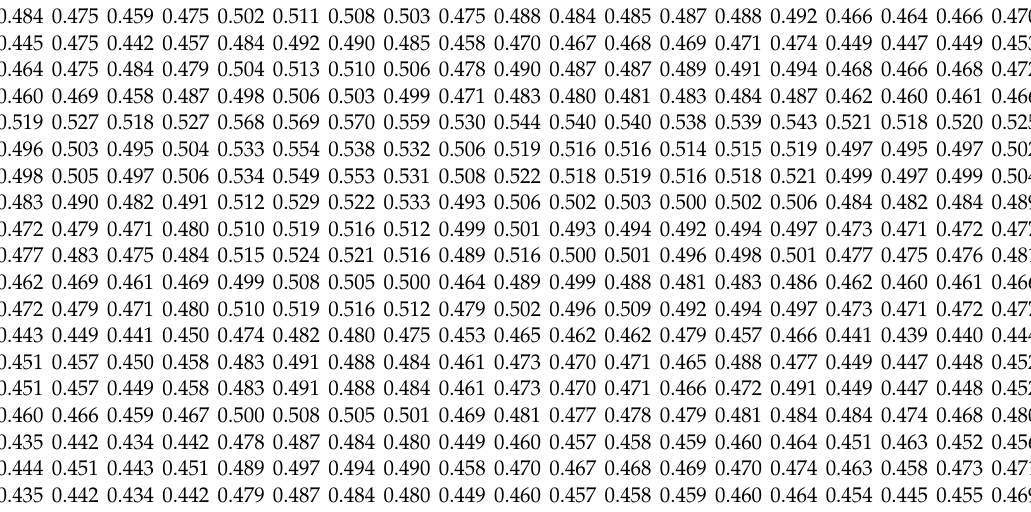
Table 5. The total influence matrix T